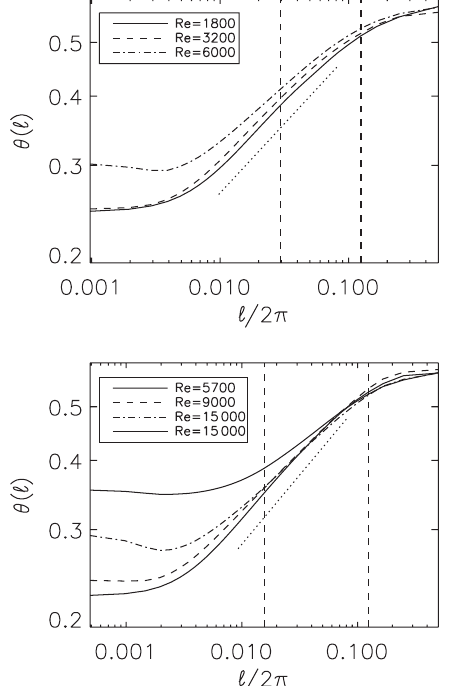
FIG. 5. Measurements of the dynamic alignment angle (4) vs scale l in balanced RMHD. Upper panel: Simulations RB2d (solid line), RB2c (dashed line), and RB2b (dash-dotted line) on 1024 3 mesh points. Lower panel: Simulations RB3a (dash-triple- dotted line) on 2048 2 (cid:8) 512 mesh points, RB3b (dash-dotted line), RB3c (dashed line), and RB3d (solid line) on 2048 3 mesh points at different Reynolds numbers. The dynamic alignment scaling extends well into the dissipation range, up to scales close to the grid cell (roughly l (cid:7) 3 grid cells). When the Reynolds number is pushed to very high values (so that the dissipation interval becomes under resolved) or the numerical resolution in the field-parallel direction is reduced, the alignment-angle scaling degrades at small scales. The vertical lines show the approximate boundaries of the inertial interval (cf. Fig. 8). The straight dotted line has a slope of 1 = 4